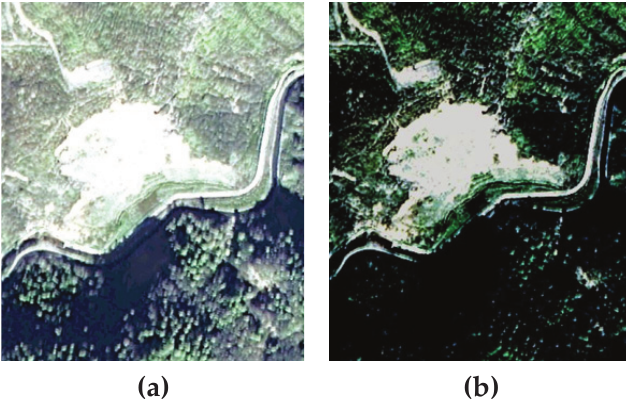
Figure 2. GF-2 remote sensing images: ( a ) original image and ( b ) contrast-enhanced